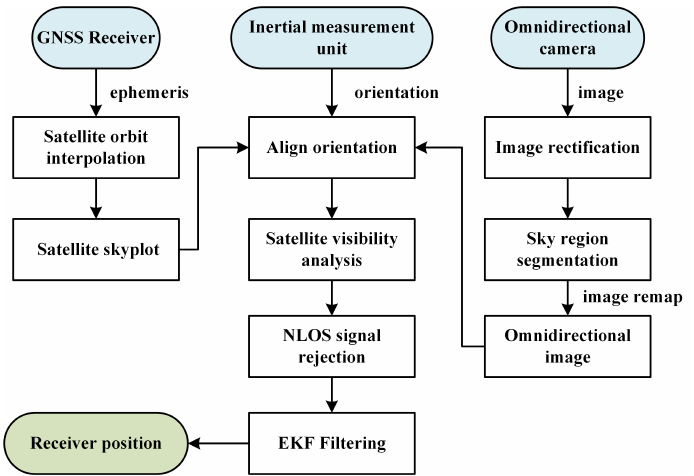
Figure 2. Flowchart of GNSS positioning with vision-aided NLOS identification.